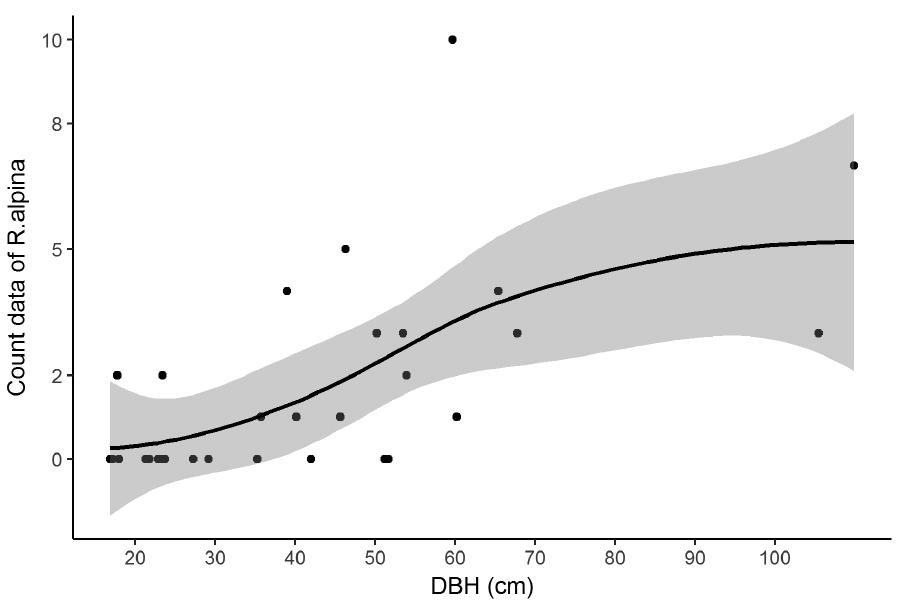
Figure 9. Visualisation of the fitted GLM model using LOESS (locally weighted scatter plot smoothing) function. The figure shows the relationship between DBH and count data of R. alpina in FC during 2016. A larger number of individuals were observed on trees with DBH greater than 60 cm.